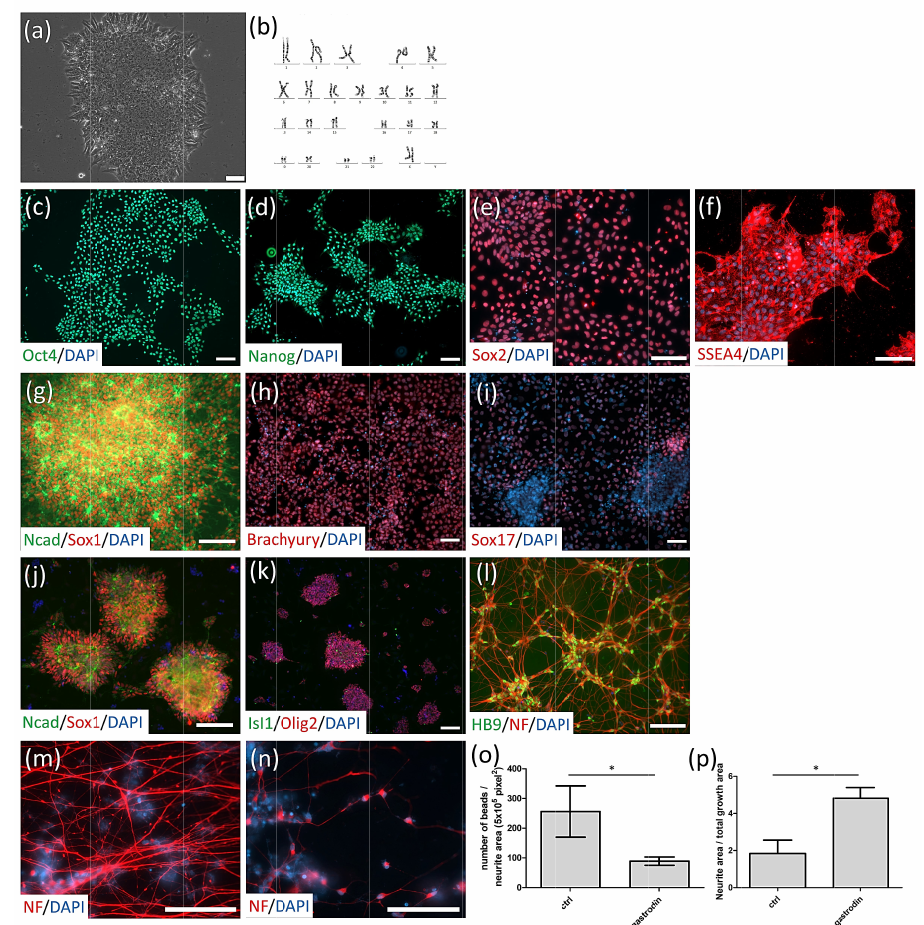
Figure 6. Gastrodin reverses nerve fiber degeneration in sporadic ALS MNs. ( a ) Morphology of sporadic ALS (sALS) iPSC clones. ( b ) Karyotype of sALS iPSCs. ( c – f ) sALS iPSC-expressed pluripotent stem cell markers including Oct-4 ( c ), Nanog ( d ), Sox-2 ( e ), and SSEA4 ( f ). ( g – i ) In vitro differentiation of sALS iPSCs into three germ layer cell types with markers including the ectoderm markers N-cadherin and Sox-1 ( g ), mesoderm marker Brachyury ( h ), and endoderm marker Sox-17 ( i ). ( j – l ) sALS iPSC line-derived MNs were identified with neural stem cell markers (N-cadherin and Sox-1) and MN progenitor markers (Oligo-2 and Islet-1) at day 15 of differentiation, and with an MN marker (HB9) and a neuronal marker (NF) at day 25 of differentiation. ( m , n ) Nerve fiber beads ( m ) and cell body inclusions ( n ) of NF protein on sALS MNs. ( o , p ) Number of nerve fiber beads ( o ) and neurite intensity ( p ) of untreated (ctrl) and gastrodin-treated sALS MNs at day 62 of differentiation. * p < 0.05. Scale bar, 100 µ